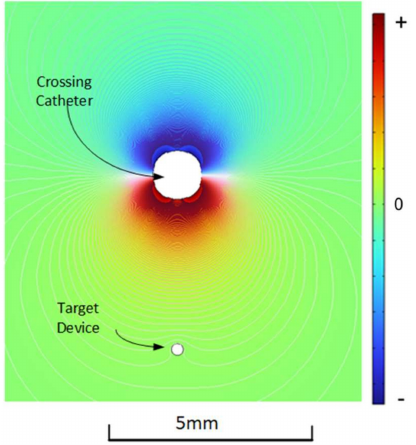
Figure 3. Spatial distribution of voltage amplitude generated.